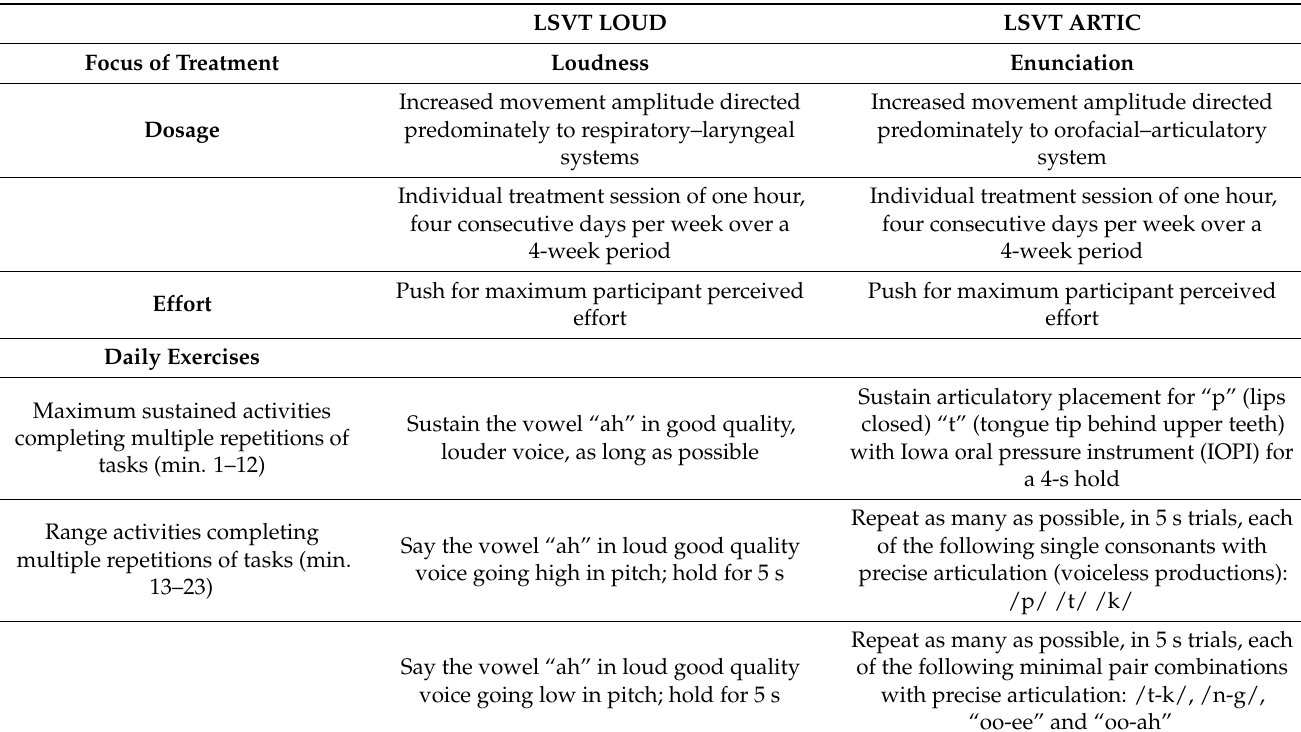
Table 2. Comparison of LSVT LOUD ® and LSVT ARTIC TM speech therapy for